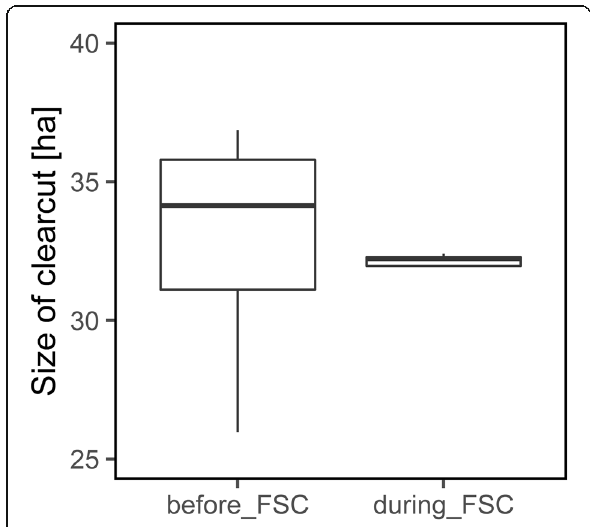
Fig. 4 Size of clearcuts before FSC certification ( n = 5) and during valid FSC certification ( n =